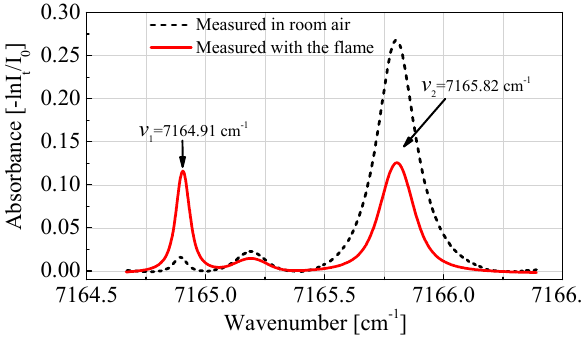
Figure 9. The obtained direct absorption signals in room air (black dot line) and in the flame (red solid line) for two transitions at v 1 = 7164.91 cm − 1 and v 2 = 7165.82 cm − 1 , respectively.